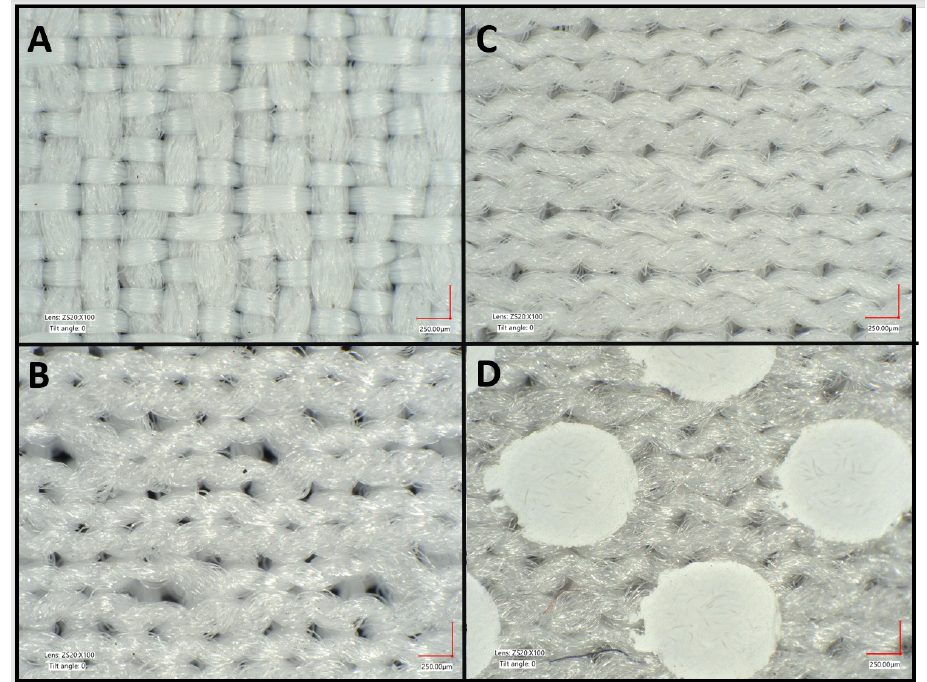
Figure 2. Four commercial fabrics were selected for study: ( A ) 107 ‐ gsm (g/m 2 ) nylon woven, ( B ) 180 ‐ gsm polyester pique knit, ( C ) 90 ‐ gsm polyester interlock knit, and ( D ) 95 ‐ gsm polyester interlock knit with TiO 2 dot print at 30% surface coverage. These fabrics are currently used in sun ‐ protective apparel. Each fabric is constructed of multifilament synthetic yarns from 50 to 160 denier. Fabric images were taken using a Keyence VHX ‐ 7000 Digital Microscope (Itasca, IL, USA). Scale bar is 250 μ m.